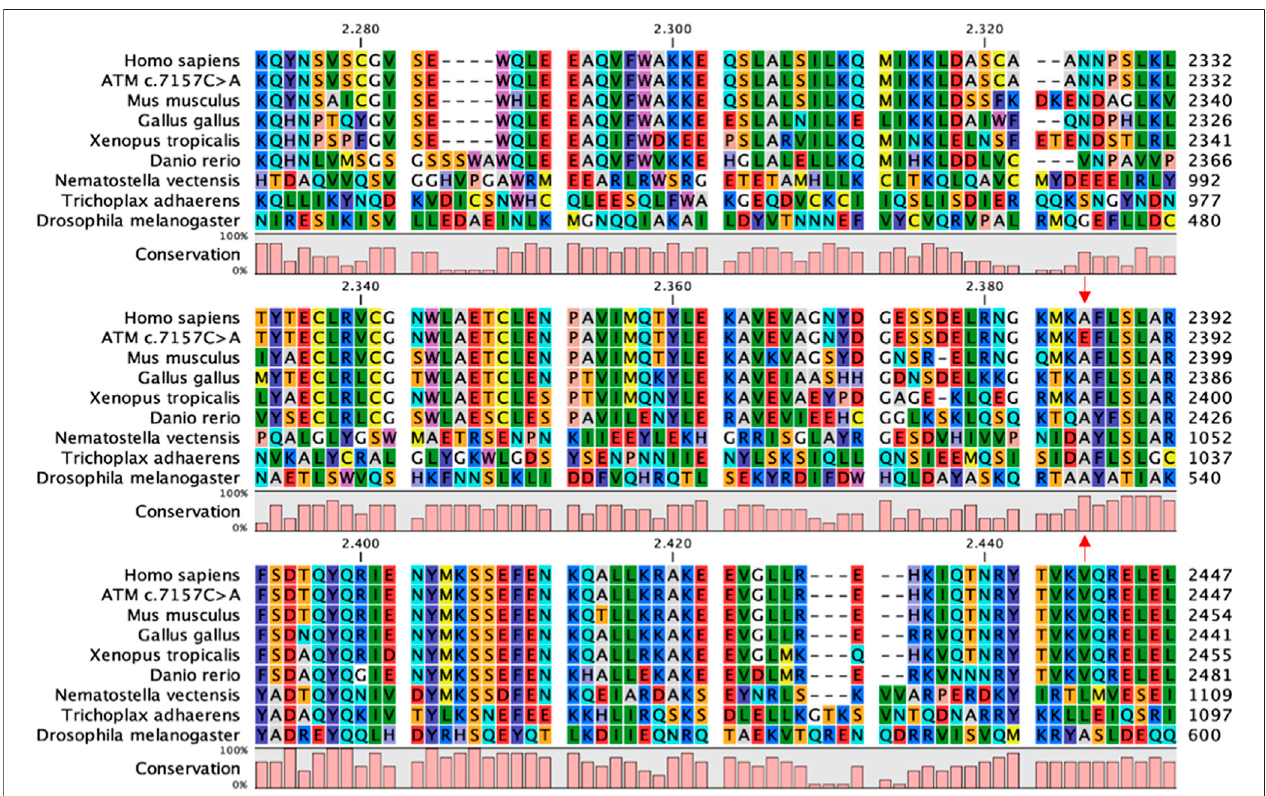
FIGURE 1 | FAT domain conservation of ATM. Portion of the multiple sequence alignment of ATM orthologous sequences performed with CLC Sequence Viewer corresponding to the FAT domain. Red arrows indicate the Ala2386, completely conserved in the considered sequences, and the corresponding non-conservative mutation in the c.7157C > A